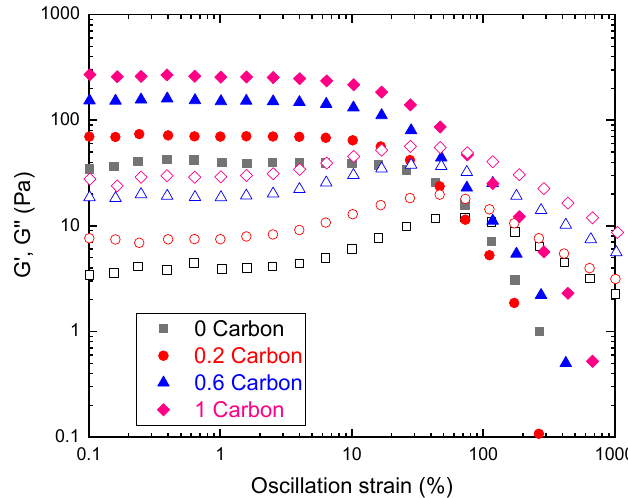
Figure 3. Oscillatory strain amplitude sweep test performed at f = 1 Hz for carbon slurries. Closed symbols represent storage moduli (G’) and open symbols loss moduli (G’’).